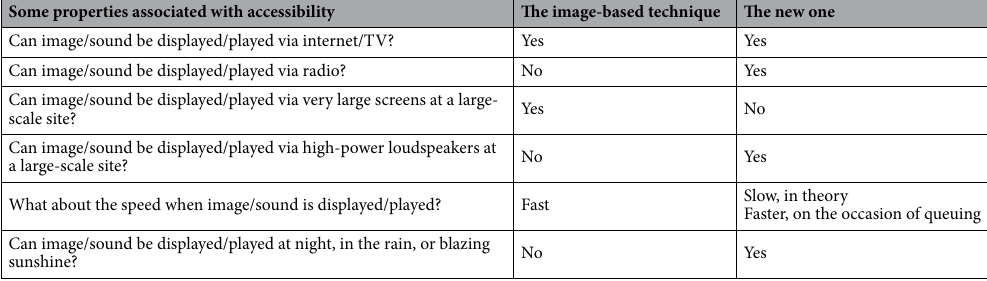
Table 10. Comparison of accessibility and robustness between the image-based technique and the new